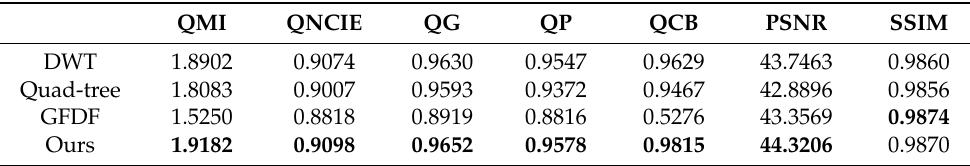
Table 2. Quantitative results for evaluation metrics on the “Bright cell” image with four other methods.